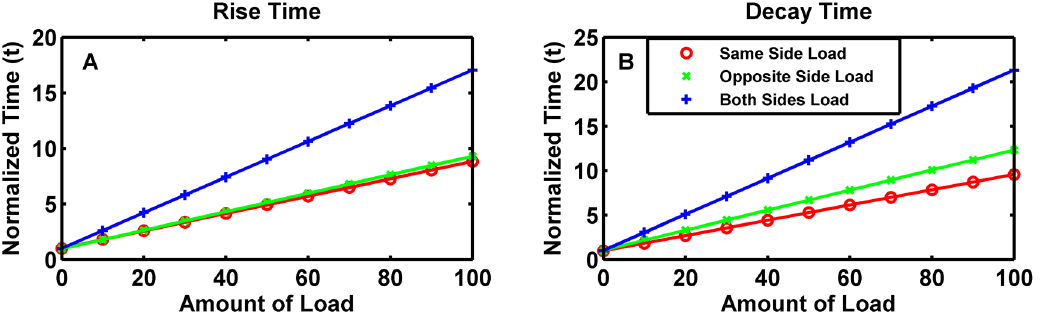
Figure 3. Effects of a load on transition times of the basic toggle switch. (A). The time taken to reach 90% of maximum value for the protein undergoing a low-to-high transition as a function of the Load, normalized by the steady-state amount of Repressor 1. Normalized time is a unit-less number defined by the transition time (rise or decay) of the system at a given loading condition divided by the transition time (rise or decay) of an unloaded system. (B). The time taken for the concentration of the protein undergoing a high-to-low transition to reach 10% of its maximum value. The x- and y- axes are the same as for the previous panel.